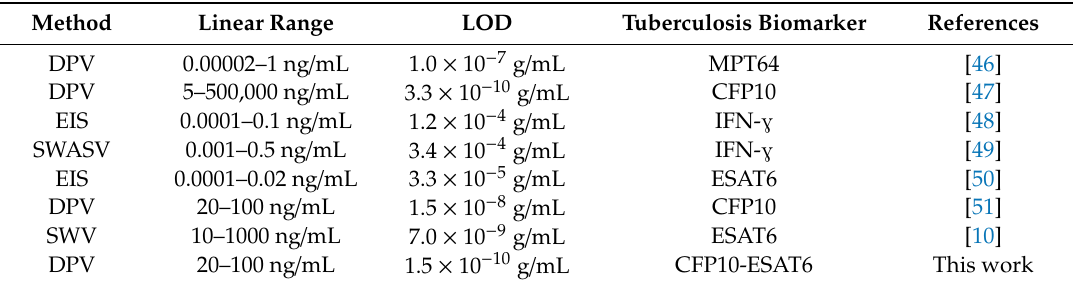
Table 1. The comparison of analytical performance of developed electrochemical immunosensor by various protein tuberculosis (TB) biomarkers.